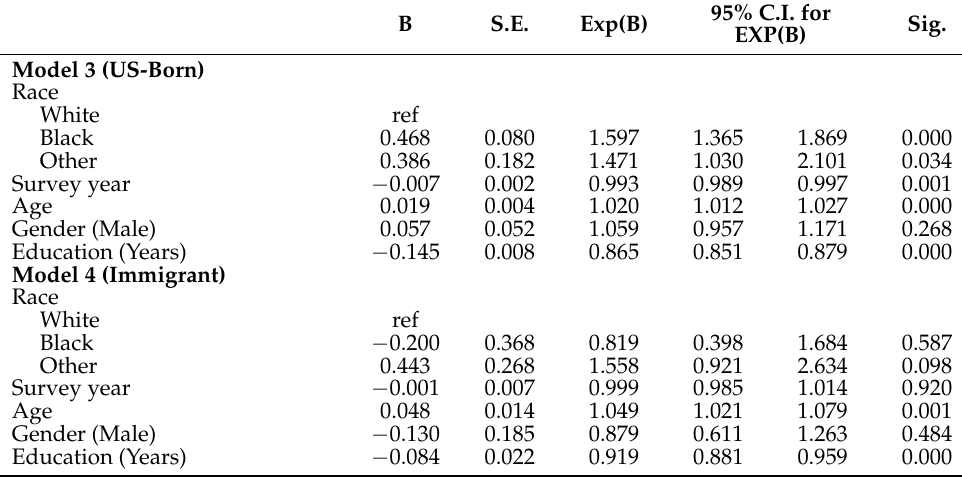
Table 3. Stratified logistic regression